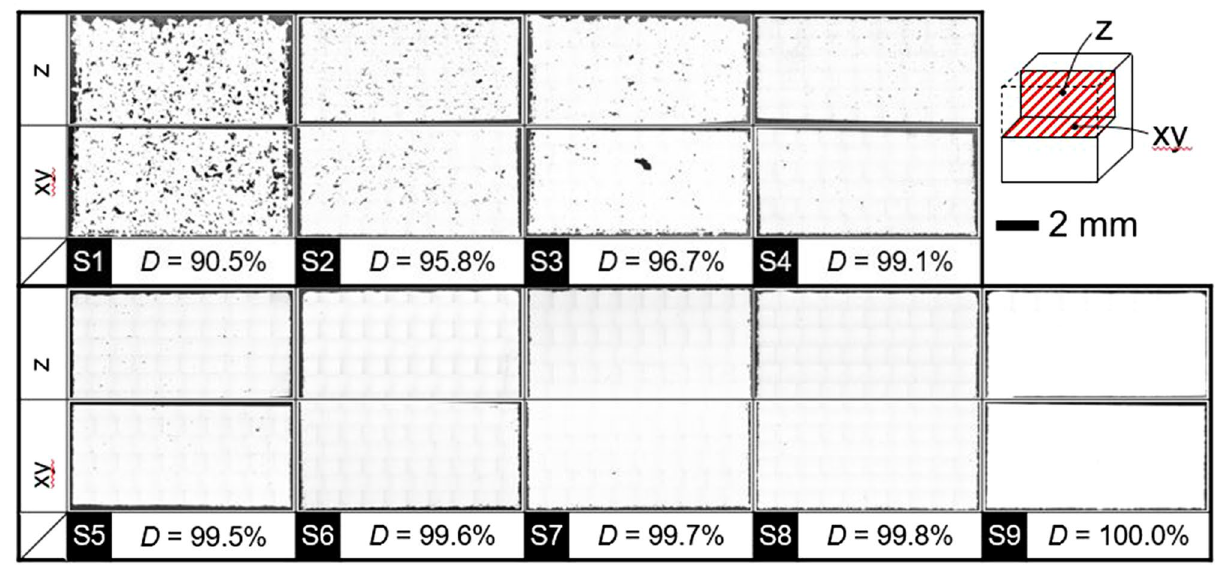
Figure 3. OM images of specimen (S1–S9) cross-sections. Images created using Mx Ver.7.3.0.5 (https:// www. zygo. com/ produ cts/ metro logy- syste ms/ metro logy- softw are/ mx- for- 3d- optic al- profi lers).